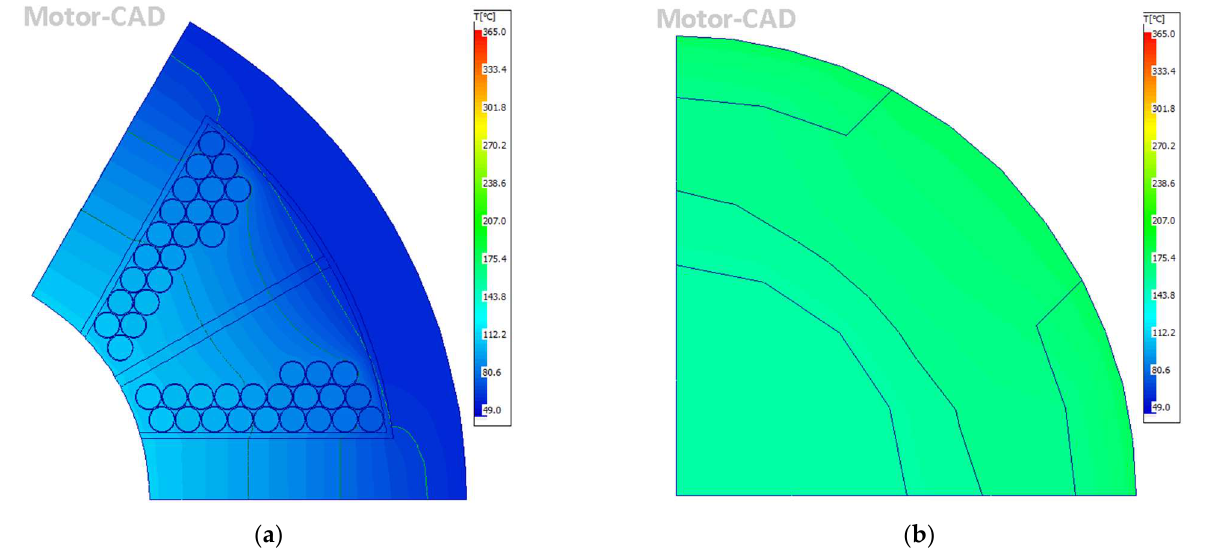
Figure 10. The distribution of temperature at steady state with duty cycle: ( a ) stator; ( b ) rotor.